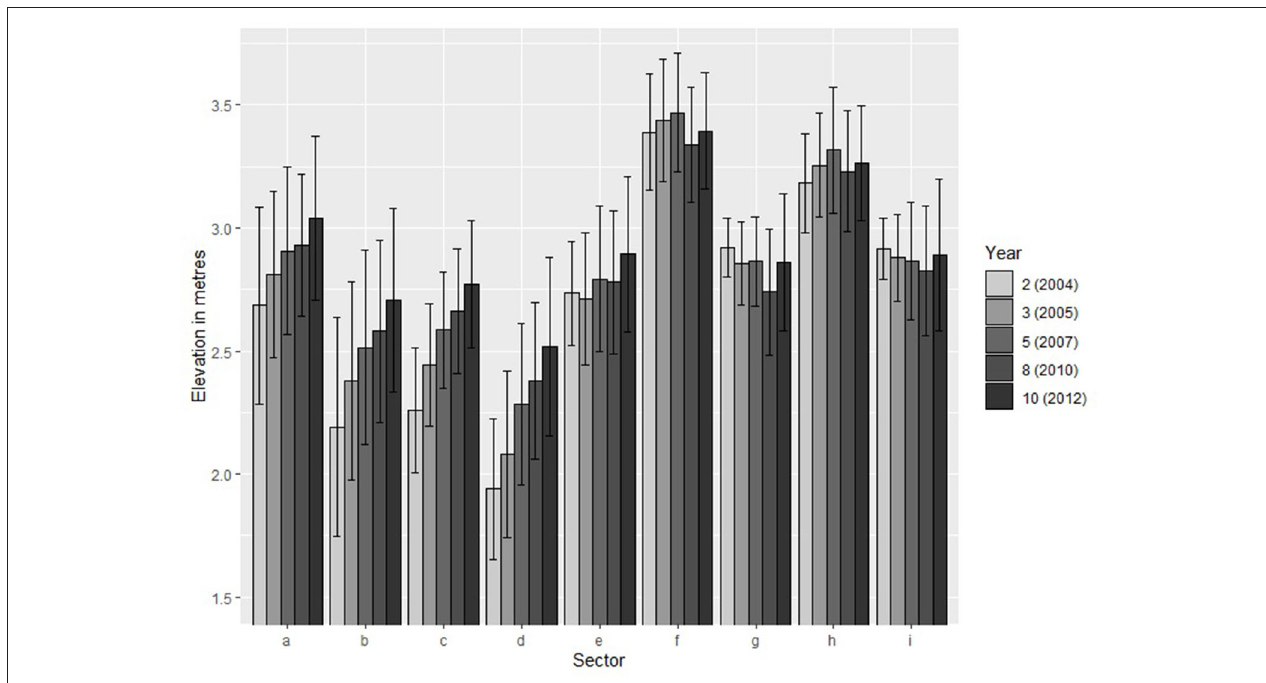
FIGURE 3 | Changes in the mean elevation of each sector of the Paull Holme Strays MR site over the study period.